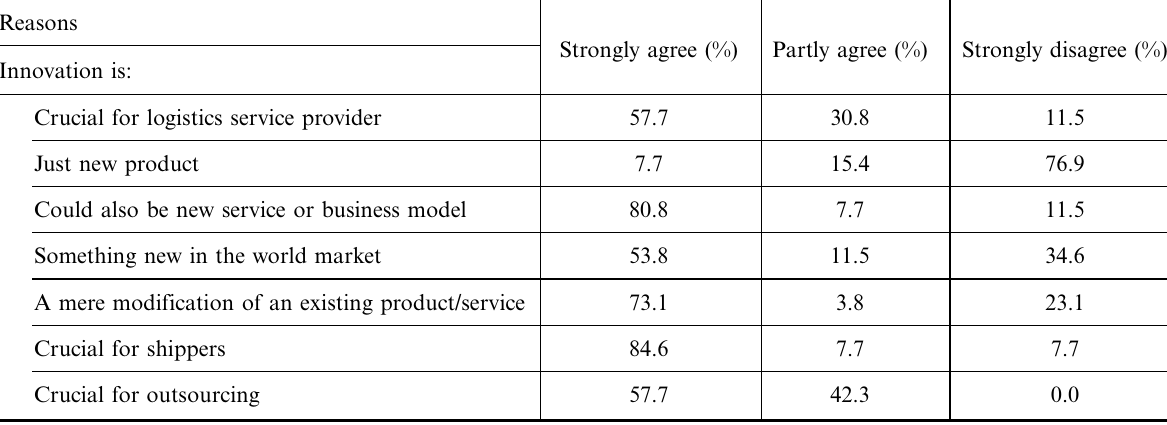
Table 3. Knowledge of innovation and an awareness of the importance of